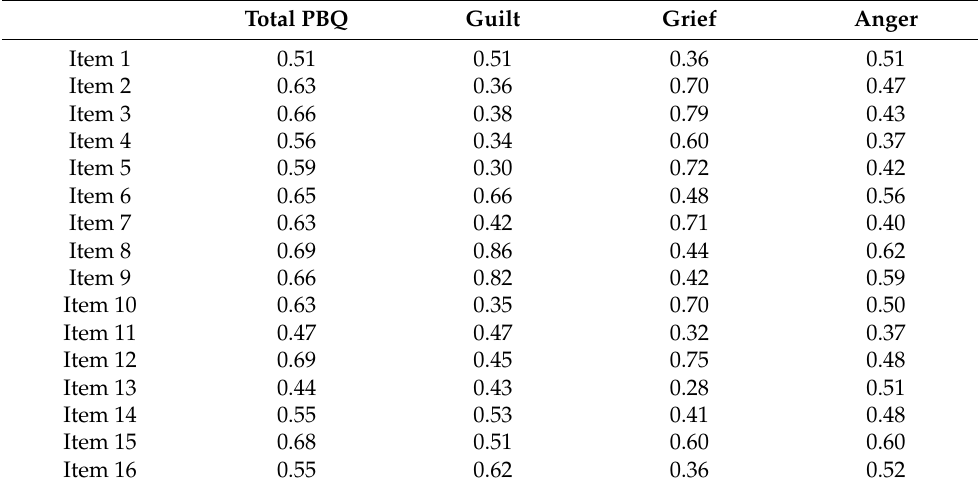
Table 2. Item-total and item-subscale correlation corrected for